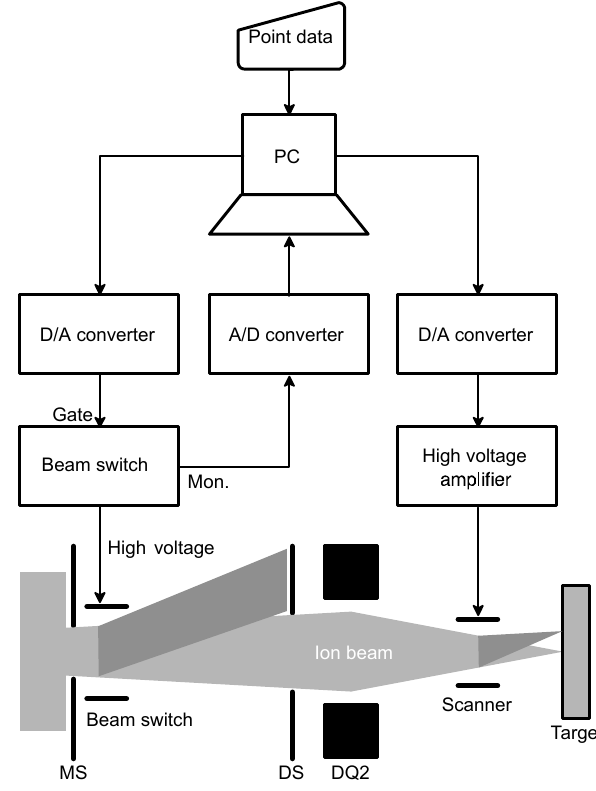
Figure 18. A schematic diagram of the PBW (proton beam writing) system.